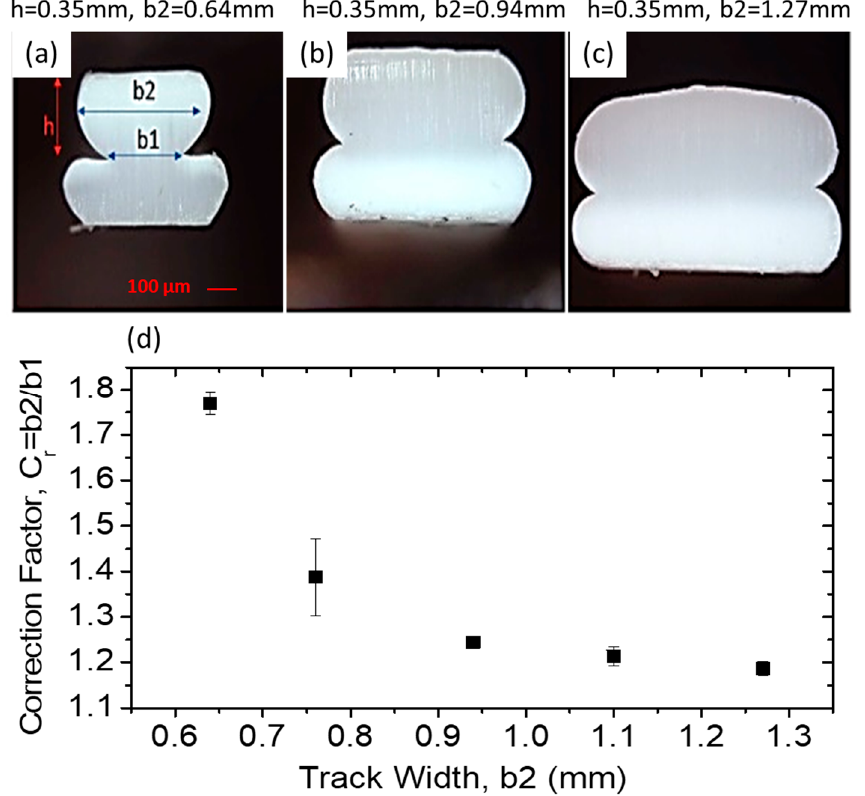
Figure 3. Effect of printed track geometry and corresponding correction factor for adhesion calculation. ( a – c ) double-layer track specimens at various widths, ( d ) correction factors applied for adhesion calculations for h = 0.35 mm with varying width. The errors bar represent the standard deviation measured at four sections for each given track width.